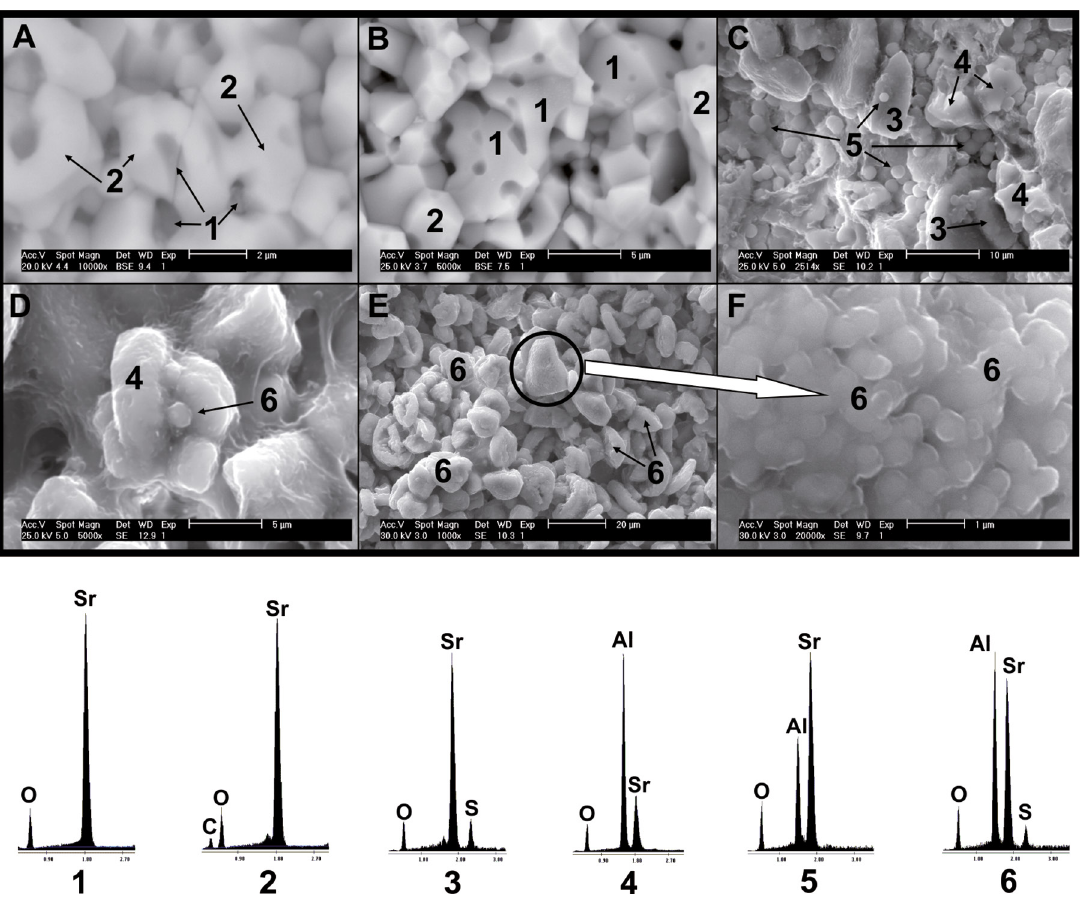
O :3SrCO :SrSO mixture, heat treated from 800 to 1150°C with 4h isotherm. A: 800°C, 2 3 3 4